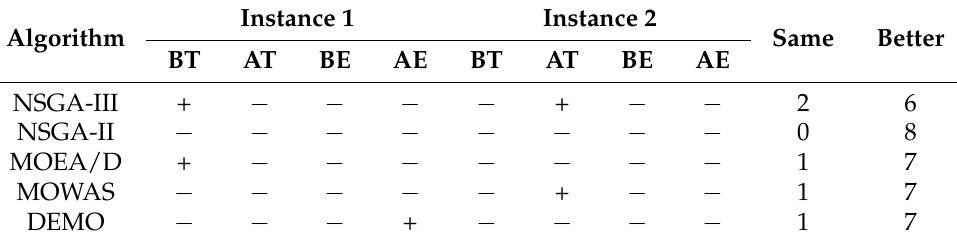
Table 13. The p values of APNSGA-III and other algorithms on Instance 1 and Instance 2.